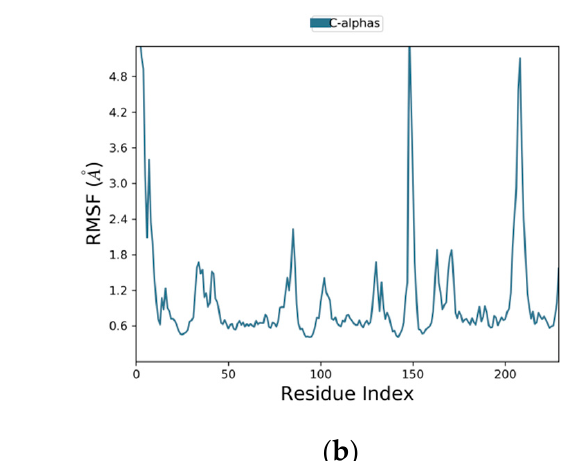
( b ) Figure 7. The plots of residue wise root mean square fl uctuation (RMSF) of receptor proteins in apo and bound states. ( a ) RMSF plot of EGFR protein (in apo and bound state) and ( b ) RMSF plot of caspase-9 protein (in apo and bound state). The red peaks are showing apo proteins, while the blue peaks are showing values for bound states. There are four di ff erent types of protein–ligand interactions or contacts, which in- clude H-bonds, water bridges, , ionic interactions, and hydrophobic interactions. In Maestro, the Simulation Interaction Diagram panel was employed for the study of sub-